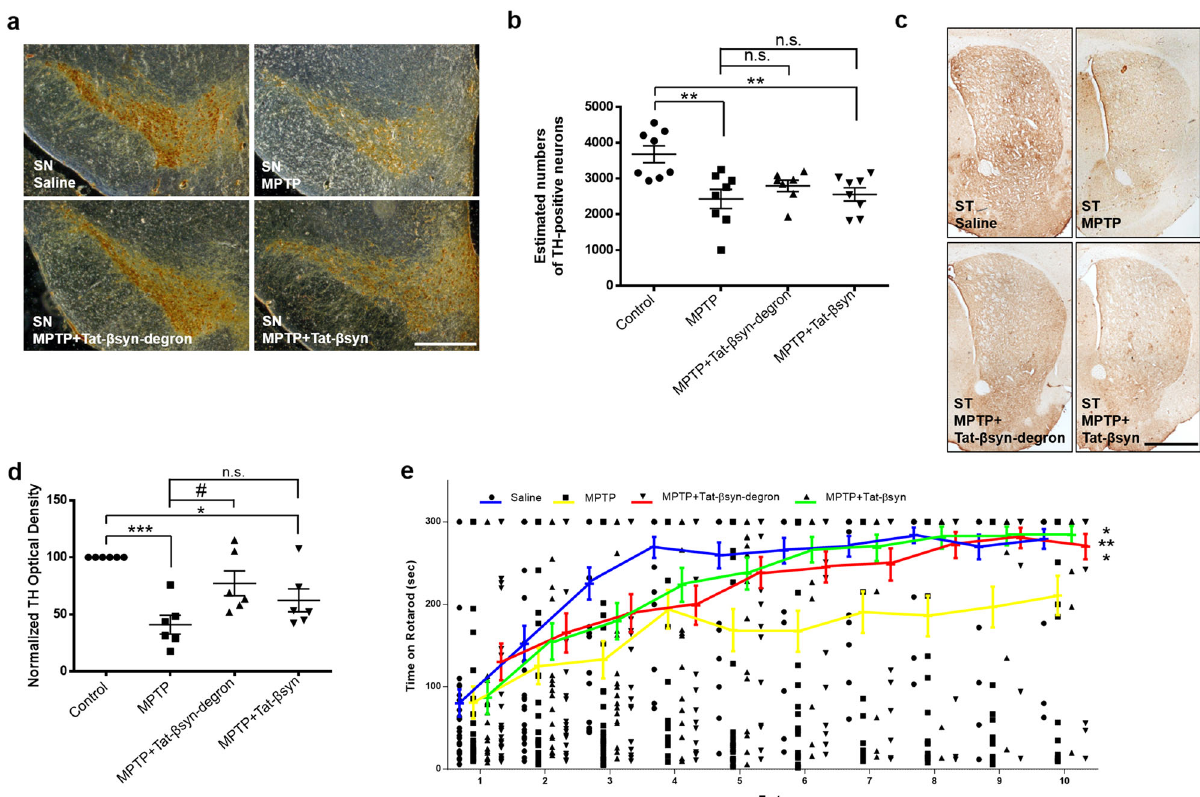
Fig. 7 Tat- β syn-degron peptide-mediated knockdown of α -synuclein protects against parkinsonian toxin MPTP-induced dopaminergic neuronal damage and behavioral de fi cits in mice. a – e Mice received i.p. injections of MPTP (30 mg/kg) or same volumes of saline once a day for 5 days, along with Tat- β syn-degron or its control Tat- β syn (6 µ mol/kg; i.p.) twice a day for 12 days. Brain tissues were collected for immunohistochemical staining of TH ( a , c